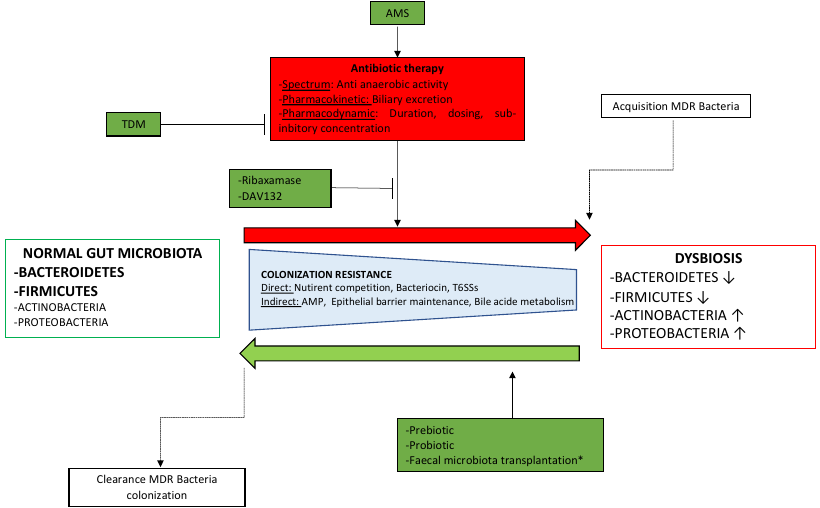
Figure 1. Impact of antibitioc therapy on gut microbiota and management of dysbiosis.